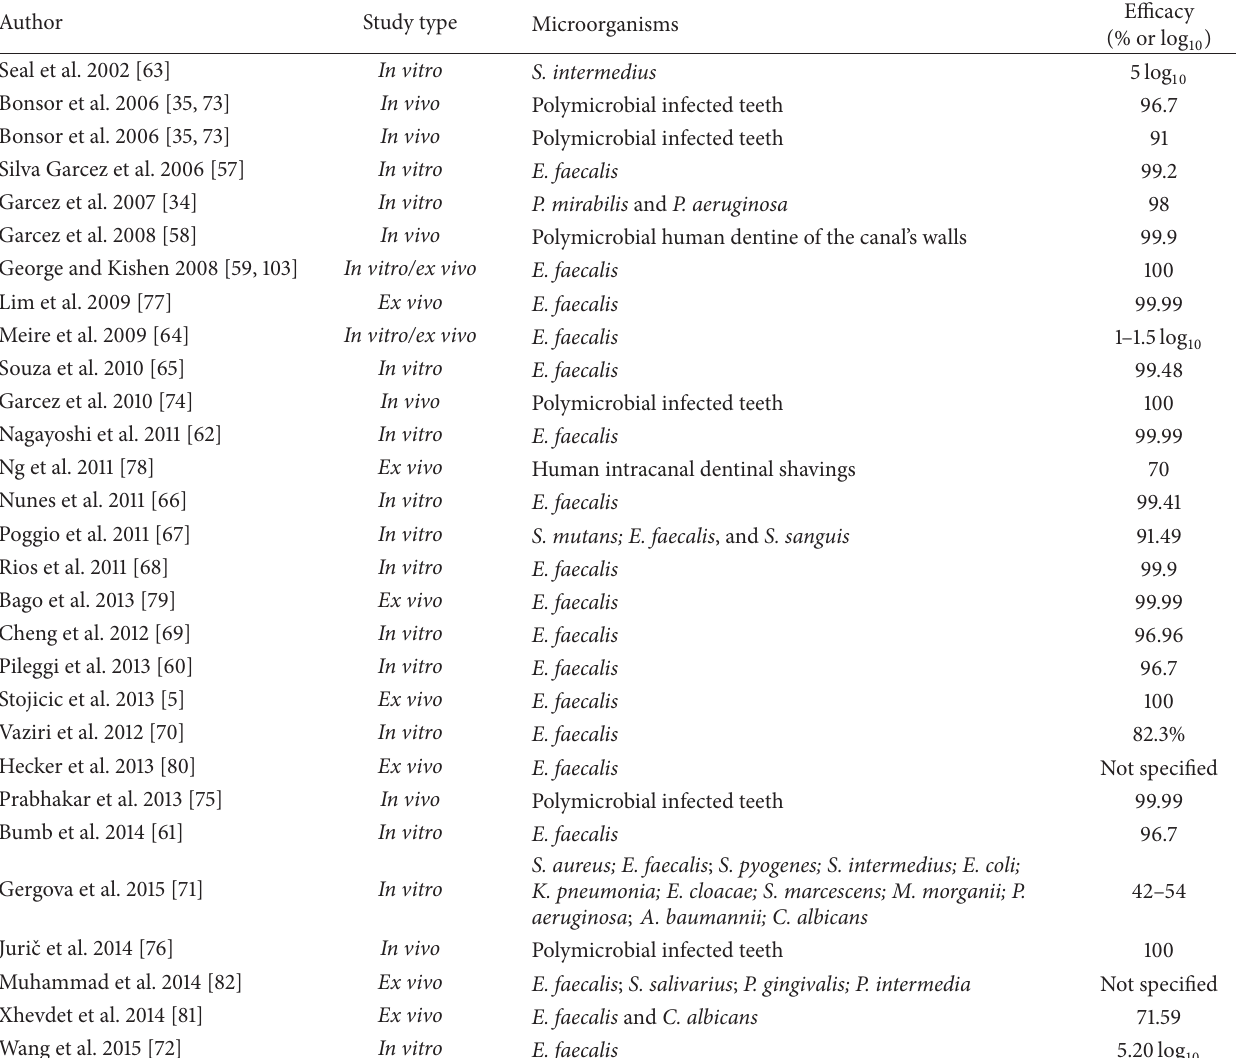
Table 4: PDT microbial reduction